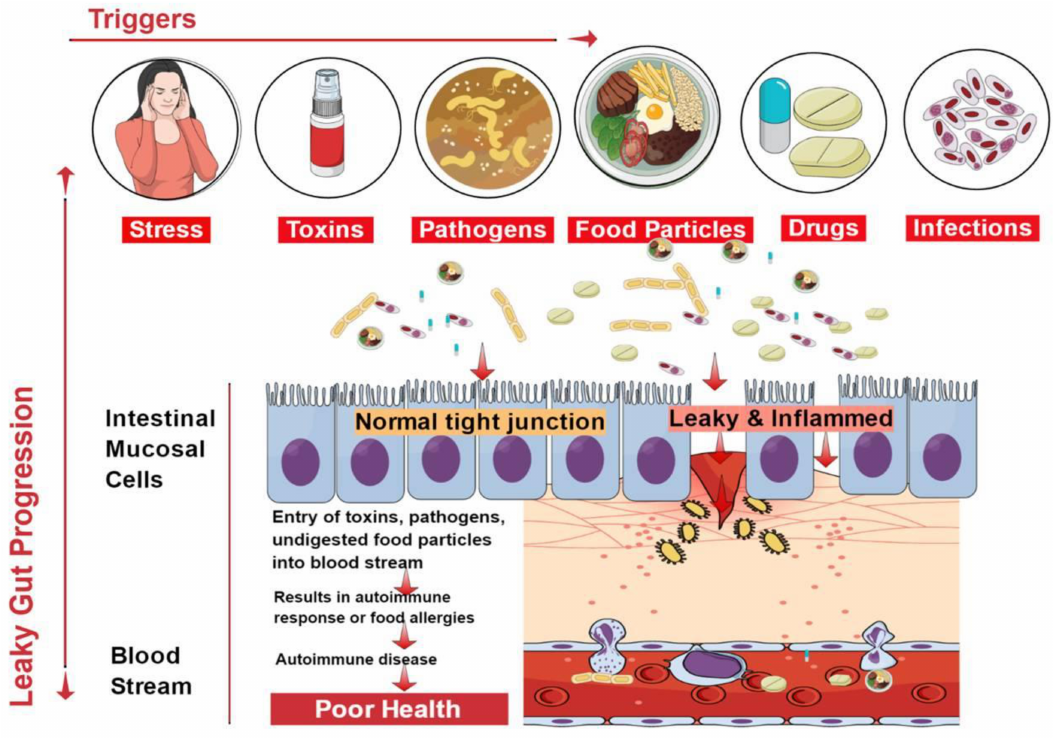
Figure 2. Factors contributing to the development of leaky gut and its relationship to autoimmune diseases. Diet, genetic susceptibility, and environmental conditions, among others, a ff ect the intestinal epithelial barrier integrity. This imbalance leads to compromised barrier integrity and contributes to several